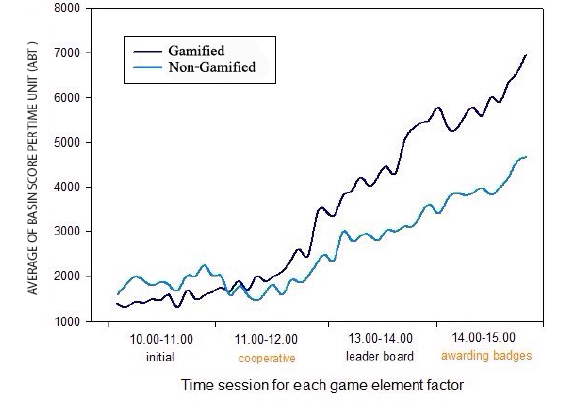
Fig. 5. Graph of the basin scores per time unit (ABT)